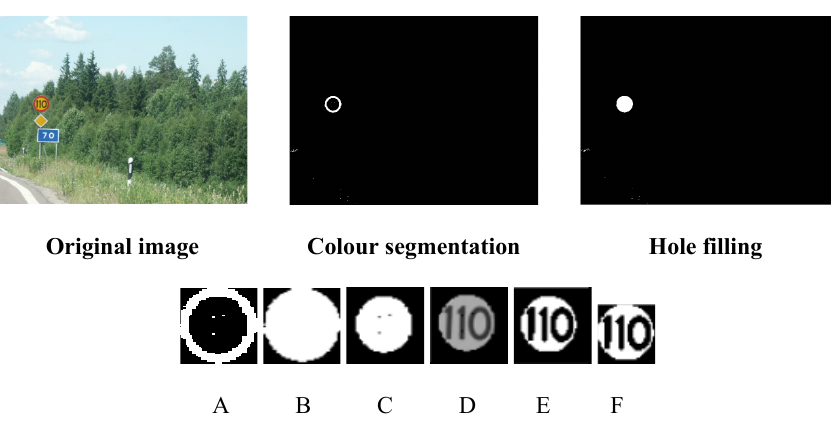
Figure 3. Steps to extract a candidate traffic signs from the